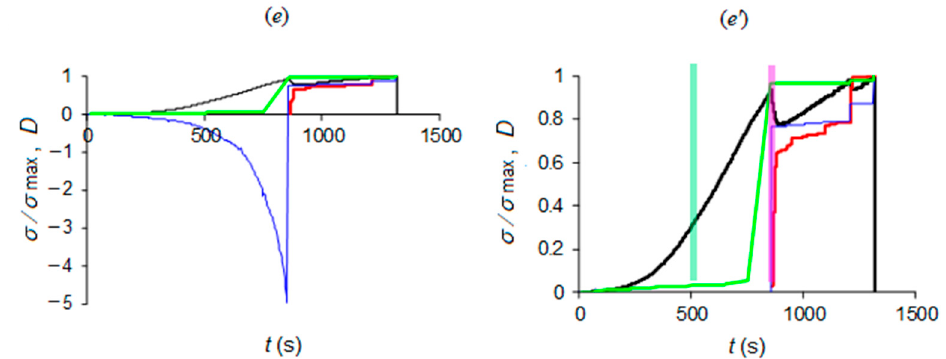
Figure 7. Times of approach to criticality by NT analysis (identified by magenta patch for AE and light green patch for electrical resistance) correlated to load history and damage evolution: the diagrams refer to CM specimens ( a , b ) and LS specimens ( c – e ) according to the inset table of Figure 3; last picture ( e’ ) magnifies the positive damage range of ( e ).